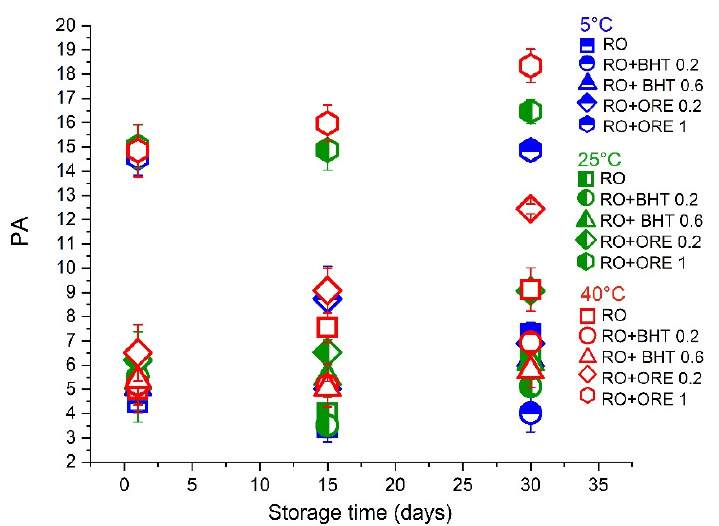
Figure 5. p-anisidine value (PA) of oil samples (pure raspberry oil–RO) and RO with added antioxidants (butylated hydroxytoluene—BHT, 0.2 or 0.6 wt%, and oregano essential oil—ORE, 0.2 or 1 wt%) during one month of storage at 5, 25, and 40 °C.